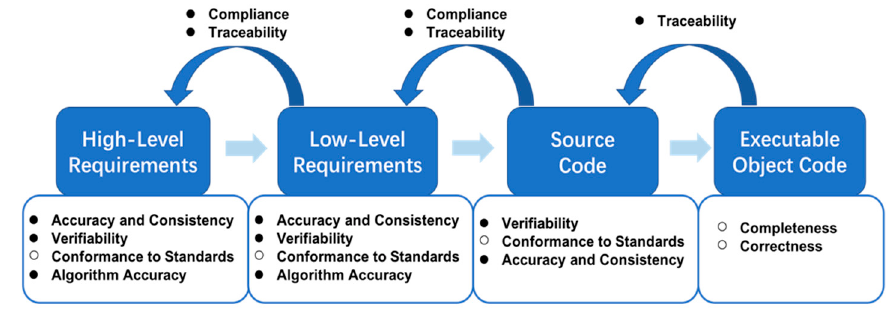
Figure 11. Achieved verification objectives.